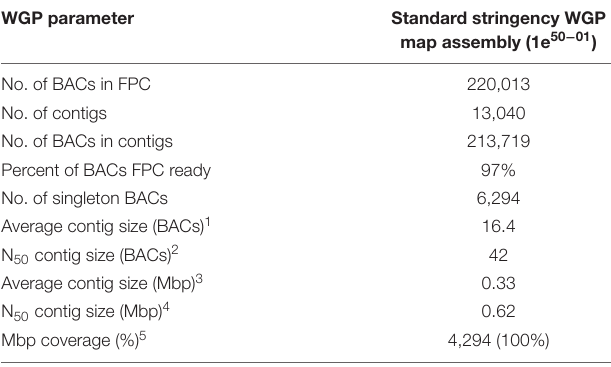
TABLE 2 | Whole genome profiling (WGP) metrics for the pea physical map construction using a 50 nt tag length and standard